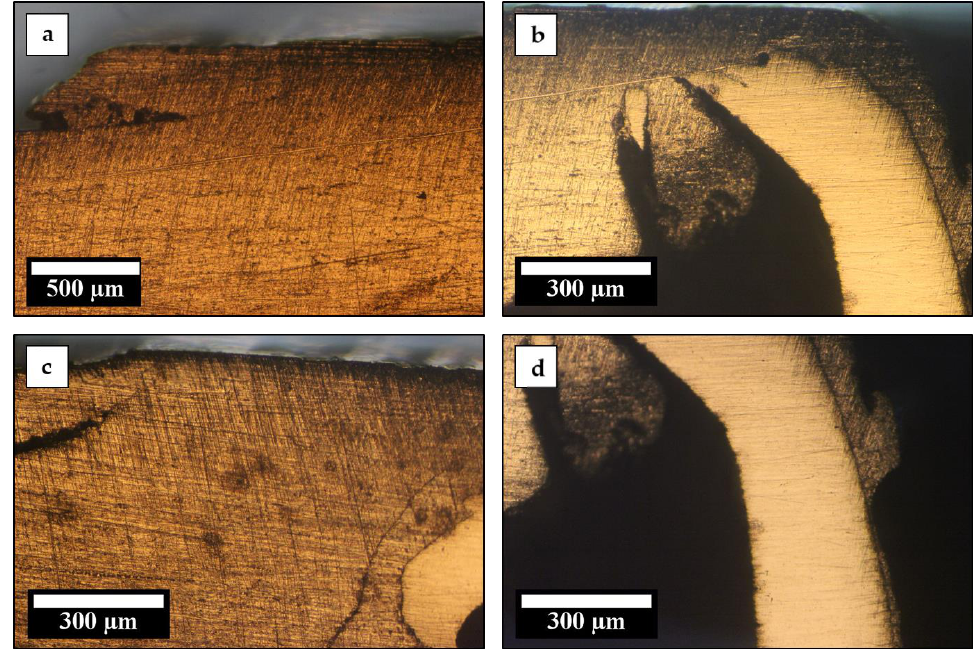
Figure 20. Optical image of the formed-joint zone under normal condition. ( a ) back-extruded of the softened materials. ( b ) formed-joint region. ( c ) high-magnified view of formed-joint region. ( d ) materials stirring in bushing